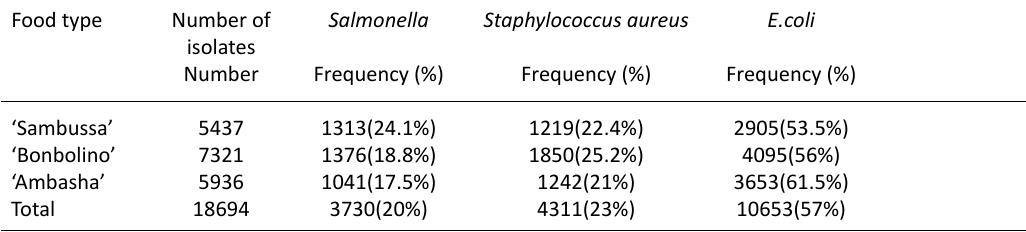
Table 5. Incidence of dominant bacteria species in some street-vended foods in Woldia town Food